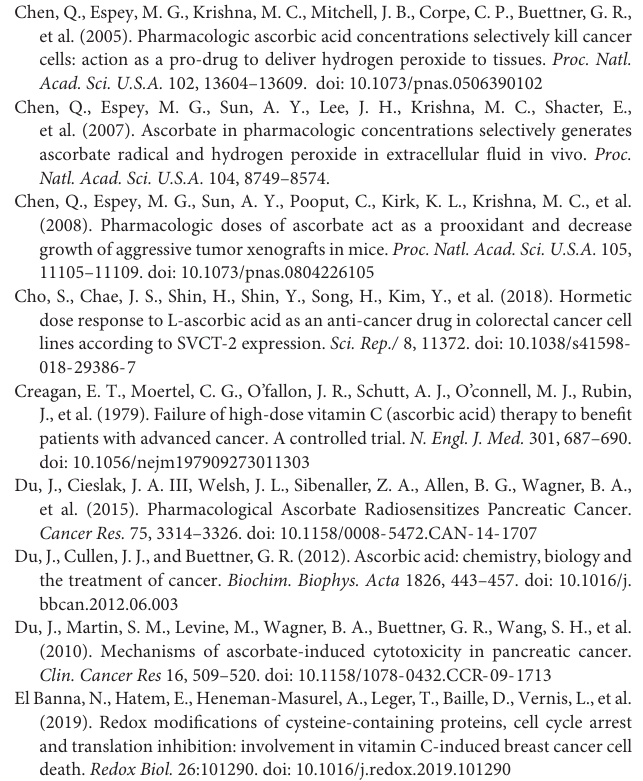
PS: figure design. GM-C and CR: funding acquisition. FR,